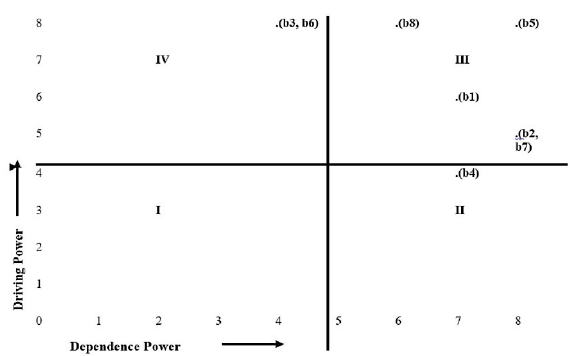
Figure 3. Driving and dependence power